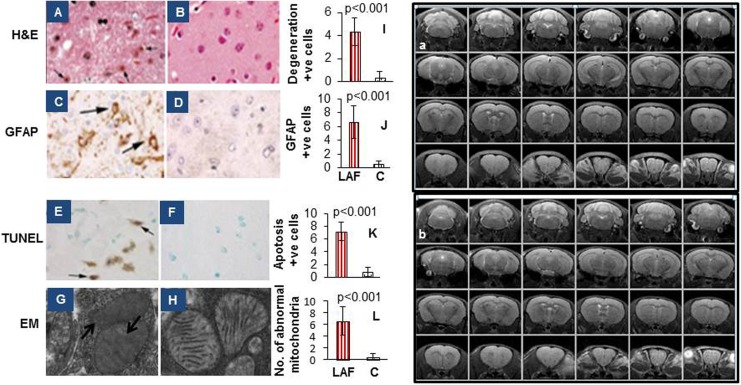
Thalamus histopathological analysis and MRI anatomic images of thalamus and brain in LALF mice. A, B, and I, H&E staining analysis of the number of positive degenerative neurons in the thalamus and quantitative data in 2 groups of LALF (A) and control (B), (C, D, and J) IHC analysis of astrocytosis in the thalamus and quantitative data in LALF (C) and control (D) animals, (E, F, and K) TUNEL staining analysis of neuron apoptosis in the thalamus, and (G, H, and L) EM analysis of mitochondrial morphological changes. The positive cell bodies (see arrows) were counted in 7 experimental animals, each group by 2 investigators in a masked manner, not knowing the classified group of sections. (H&E, 200×; IHC GFAP staining, 200×; TUNEL staining, 200×; EM, 6500× and 0.002 mm/pix). In the right panel (a) T2-weighted brain images from frontal to cerebellum of an LAF animal and (b) T2-weighted brain images from frontal to cerebellum of a control animal. There was no anatomic damage in either LALF animals or controls. EM indicates electron microscopy; GFAP, Glial fibrillary acidic protein; H&E, hematoxylin and eosin; IHC, immunohistochemistry; LALF, late-stage alcoholic liver fibrosis; MRI, magnetic resonance imaging; TUNEL, Terminal deoxynucleotidyl transferase (TdT) dUTP Nick-End Labeling.